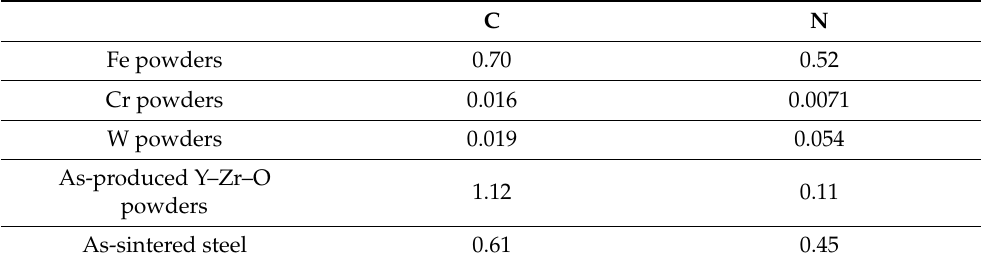
Table 3. Contents of C and N in the raw powders and as-sintered steel (wt.%).